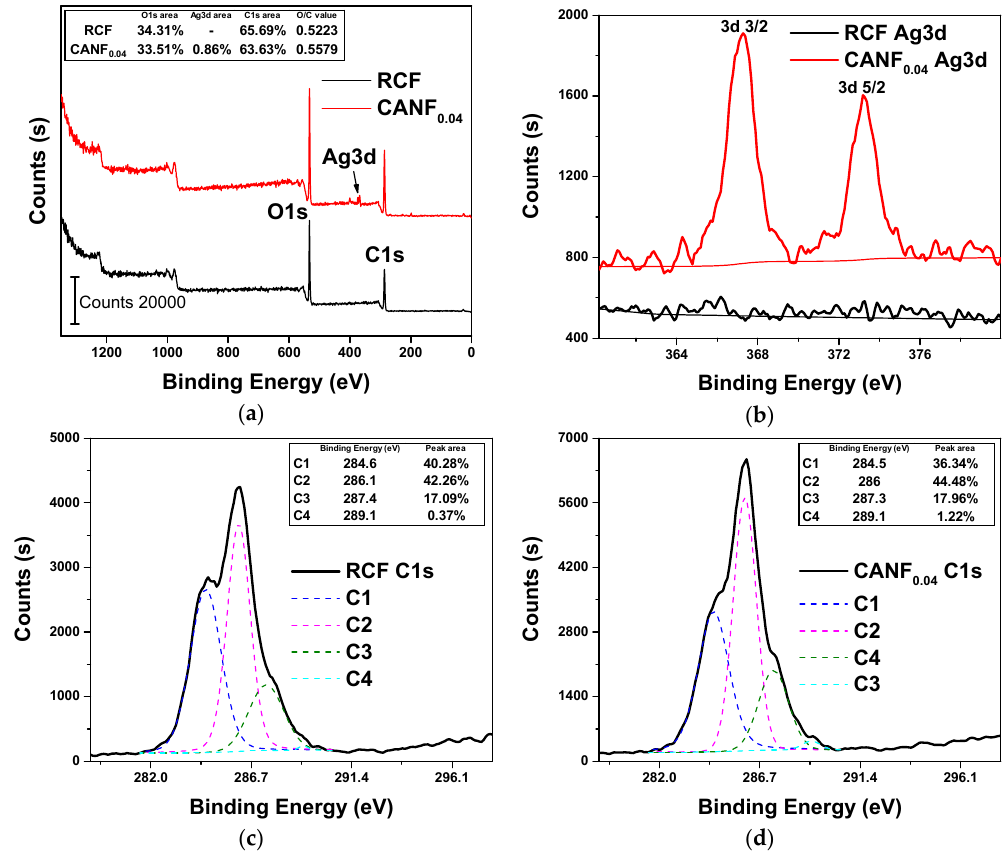
Figure 6. Surface element composition of RCF and CANF 0.04 : ( a ) Full scan spectrum of two films; ( b ) Scan spectrum of Ag3d peaks in two films; ( c ) Scan spectrum of C1s peaks in RCF; ( d ) Scan spectrum of C1s peaks in CANF 0.04 .